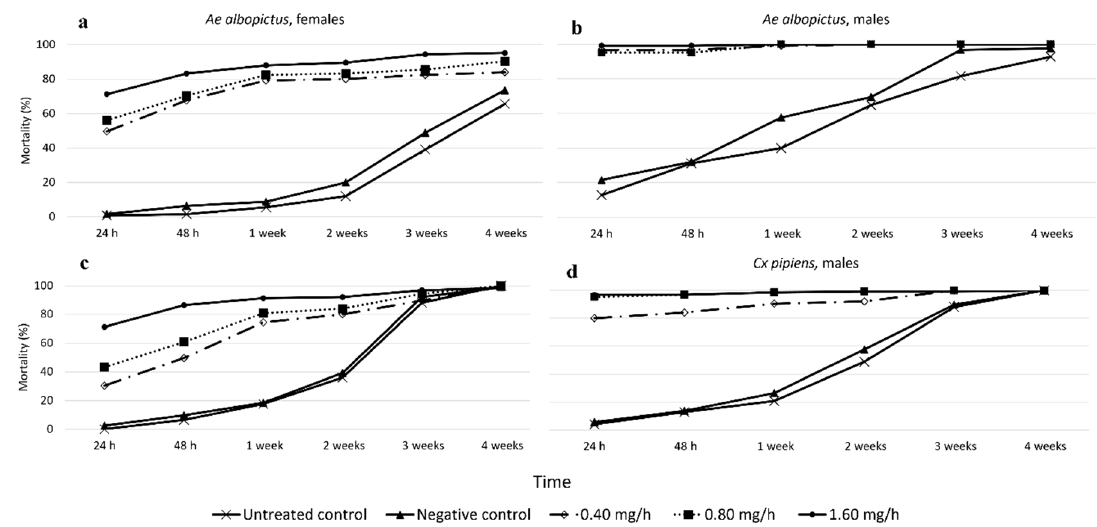
Figure 5. Mosquito mortality during the 4-week post-treatment period across the five treatment groups: ( a ) Female Ae. albopictus , ( b ) male Ae. albopictus , ( c ) female Cx. pipiens , and ( d ) male Cx. pipiens . Mortality at 24 h and 48 h is also shown to clarify the relationship between STM and LTM. LTM, long-term mortality; STM, short-term